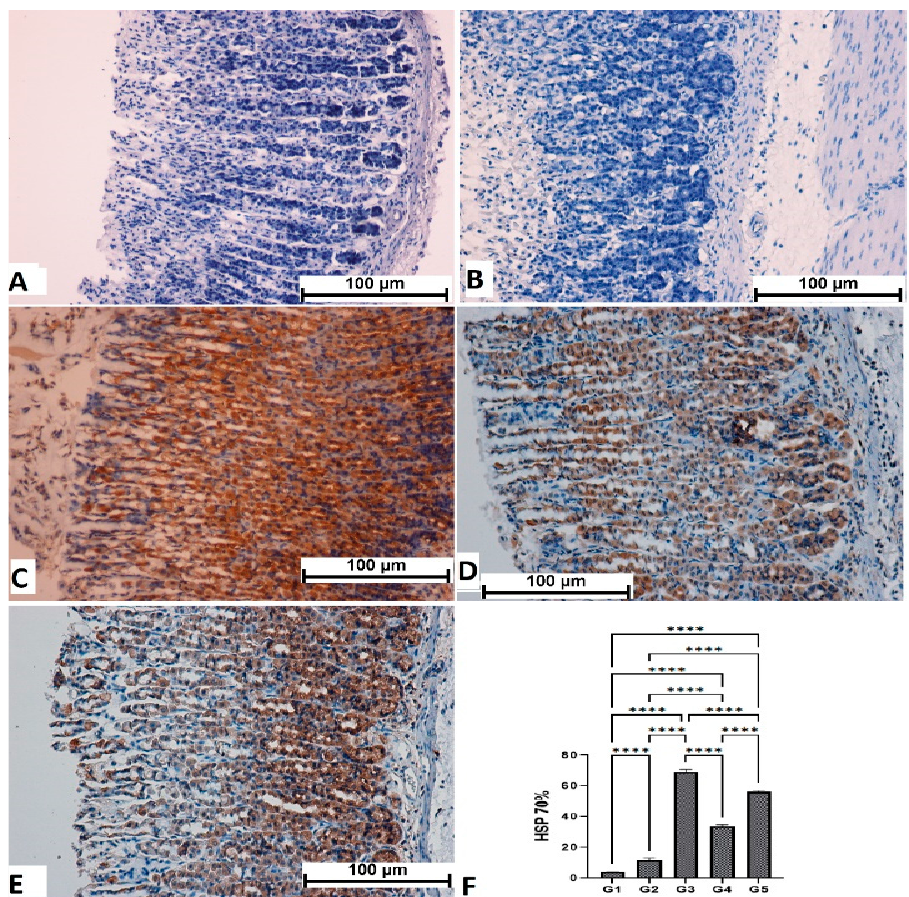
Figure 6. Influences of the PDE on the microscopic views of the stomach mucosa based on the HSP70 protein representation ( A – E ) and quantitative statistics ( F ) of the HSP70 protein expression by the stomach mucosa obtained from the ethanol ‐ induced ulcerogenic rats. ( A ), normal control; ( B ), ulcer control; ( C ), reference rats (omeprazole, 20 mg/kg); ( D ), rats received 200 mg/kg of the PDE; ( E ), rats received 400 mg/kg of the PDE. Normal control rats had a normal structure of the stomach mucosa and a low representation of the HSP70 protein in their stomach tissues ( A , F ). Ulcer control rats showed severe stomach tissue injury with significantly very low HSP70 protein representations in their stomach tissues compared to other treated groups ( B , F ). Reference rats experienced a mild stomach tissue injury with an increased expression of the HSP70 protein in their gastric mucosa ( C , F ). Rats administered 200 mg/kg of the PDE had moderate stomach lesions with increased repre ‐ sentations of HSP70 in their stomach tissues ( D , F ). Rats administered 400 mg/kg of the PDE showed a mild stomach tissue injury with increased representations of HSP70 protein, compared to the ulcer controlled rats ( E , F ). (HSP70 stain, magnification 20×). Values expressed as means ± SEM. The anti ‐ gen area is observed in a brown color. The significant difference in the HSP 70% protein expressions are presented as p < 0.0001 (****).